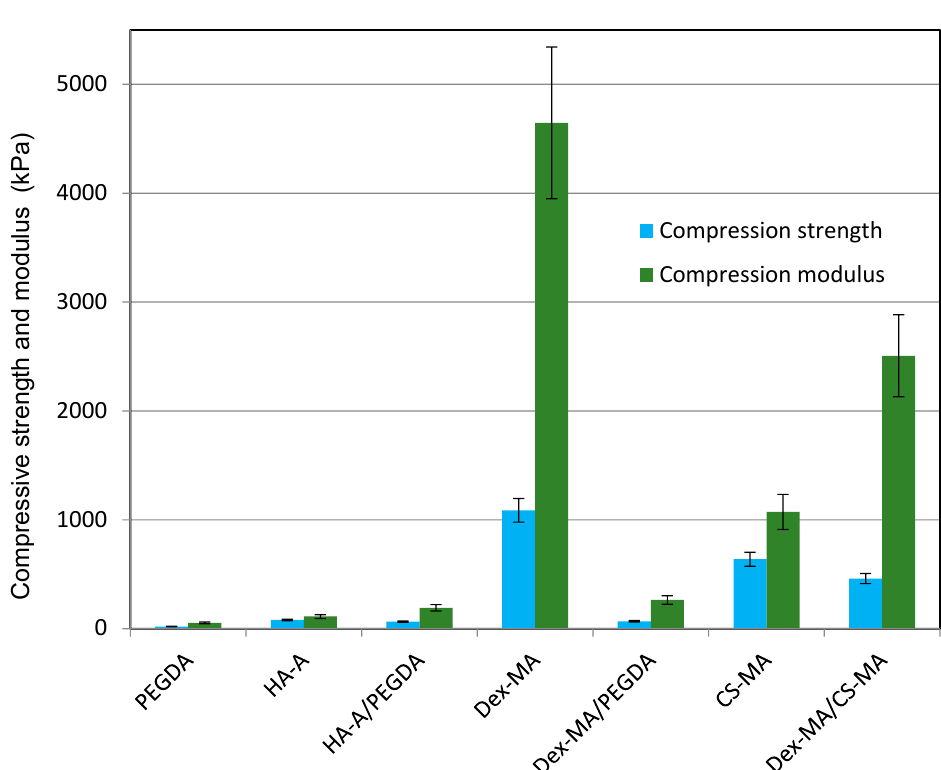
Figure 8. Mechanical strength at 50% deformation and compression modules of GAG-based cryogels in comparison to polysaccharide and synthetic polymer-based cryogels are shown. PEGDA = polyethylene glycol diacrylate; HA-A = hyaluronan acrylate; Dex-MA = dextran methacrylate; CS-MA = chondroitin sulfate methacrylate.